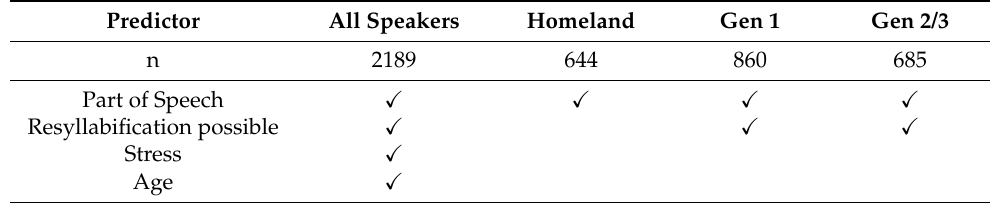
Table 5. Significant predictors (indicated with “ (cid:88) ”) in MEMs comparing Full vs. Reduced&Deleted vowels, for each speaker